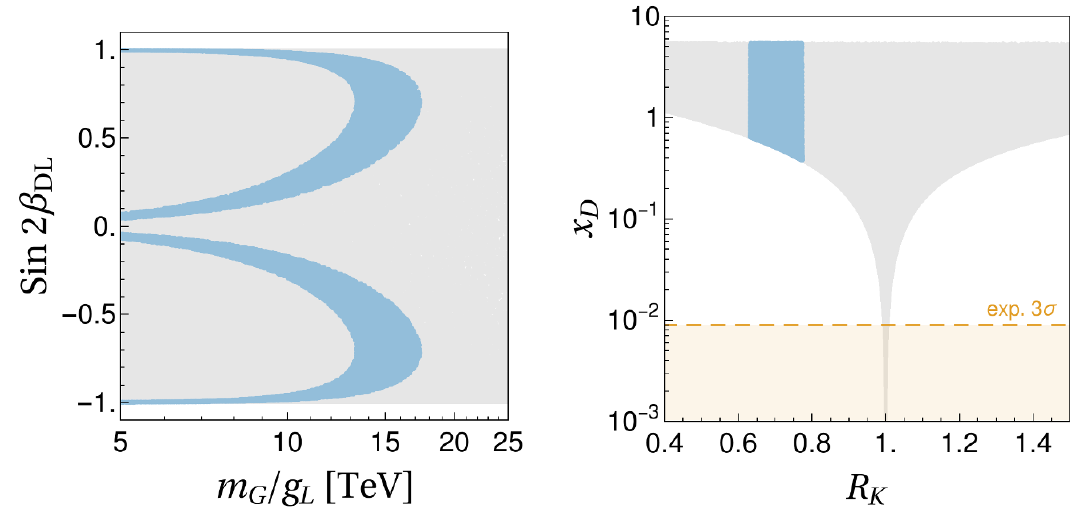
Figure 1 . Two relevant projections of the model parameter space within scenario 0. Gray points ful(cid:12)l all constraints except R K and x D . Light-blue points ful(cid:12)l also R K . The dashed line represents the 3 (cid:27) upper bound on x D from ref.